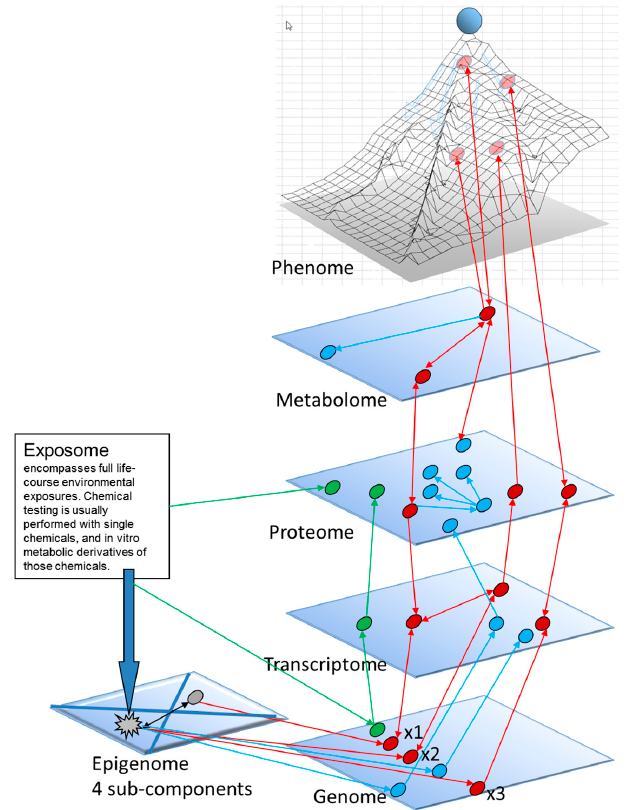
Figure 3. Hypothetical epigenetic pathway of toxicity pathways (showing key causal events) leading to adverse phenotypic changes in an experimental cellular system sensitive to changes among multiple “omic” levels and in keeping with Waddington’s metaphorical epigenetic landscape sub-structure, controlled by developmental genes. In this case, the target portion of the phenome consists of an epigenetic landscape determining the developmental fates of a tissue stem or progenitor cell (as drawn in Figure 2). In concert with one-another, the interacting “omic” domains participate in creating the observable “landscape” of physiological and molecular features that provide “shape” to an observable cellular phenotype. The epigenome, rather than being a single classification of molecular structure, is a functional categorization that is composed of several categories of molecular species. The four molecular sub-categories in the epigenomic domain considered in this review (see Figure 4) include protein, non-coding RNA and metabolite-derived covalent modifications of histones and DNA that have phenotypic consequences in cell transformation systems. The exposome potentially interacts at many places within the landscape, including the epigenome. The pathway schematic portrays an hypothetical situation in which chemically-induced perturbations to the epigenome subsequently propagate through the system-level domains, from gene transcriptional alterations, to perturbations in metabolite concentrations or structural protein expressions that are shown to affect or divert developmental choices at critical steps shaping cellular identity. PoT: A Pathway of Toxicity is a molecular definition of the cellular processes shown to mediate adverse outcomes of toxicants [21]. Pathway components: red, causal events; blue, consequential/associated events; green, coincidental events. Over the last decade, the field of epigenetics has become more sharply focused and considerably strengthened by a rapidly accelerating number of molecular studies. Research activity is now centered on several interacting molecular domains closely associated with genomic DNA and acting to impart long-term, or heritable modulations of gene expression programs (networks) determining cellular identity. This extensive body of work has explored the elaborate network of molecular